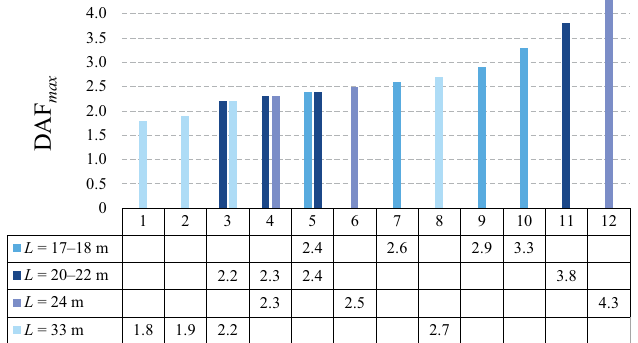
Figure 8. Pre-stressed beams (with wire rods)